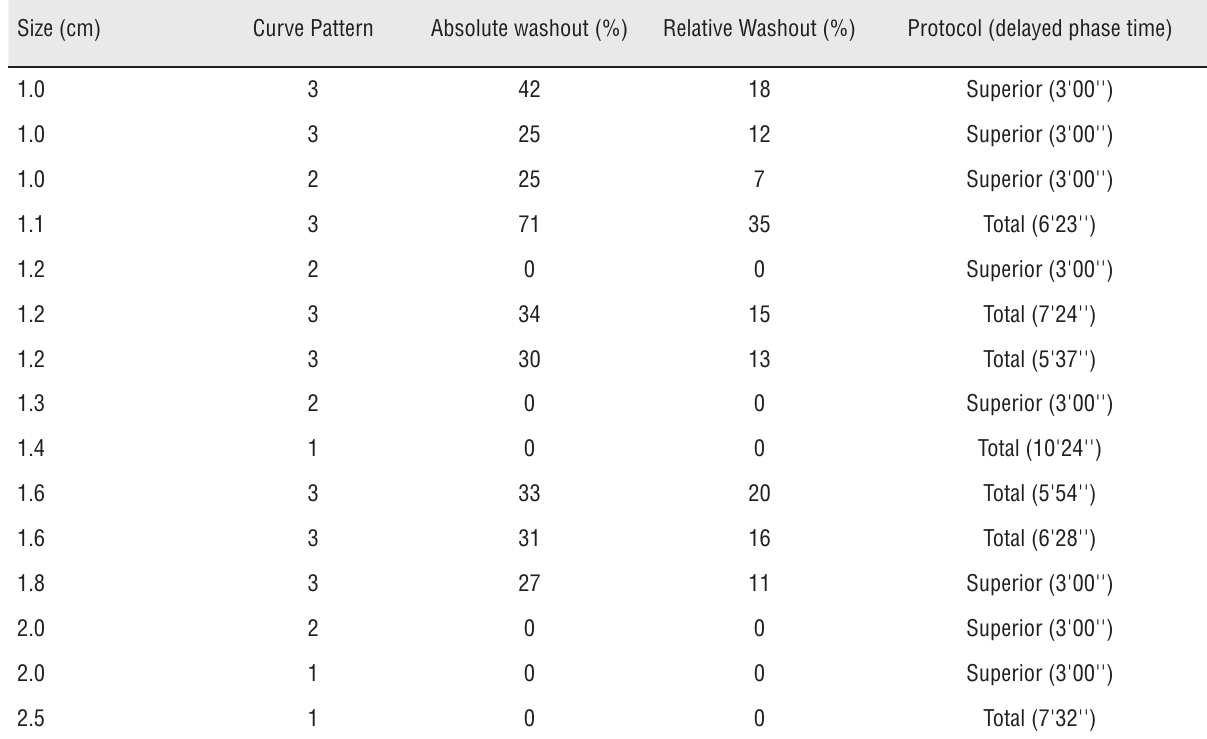
Table 1 - Size, enhancement pattern and protocol performed on magnetic resonance imaging of the evaluated lipid poor adrenal adenomas (N=